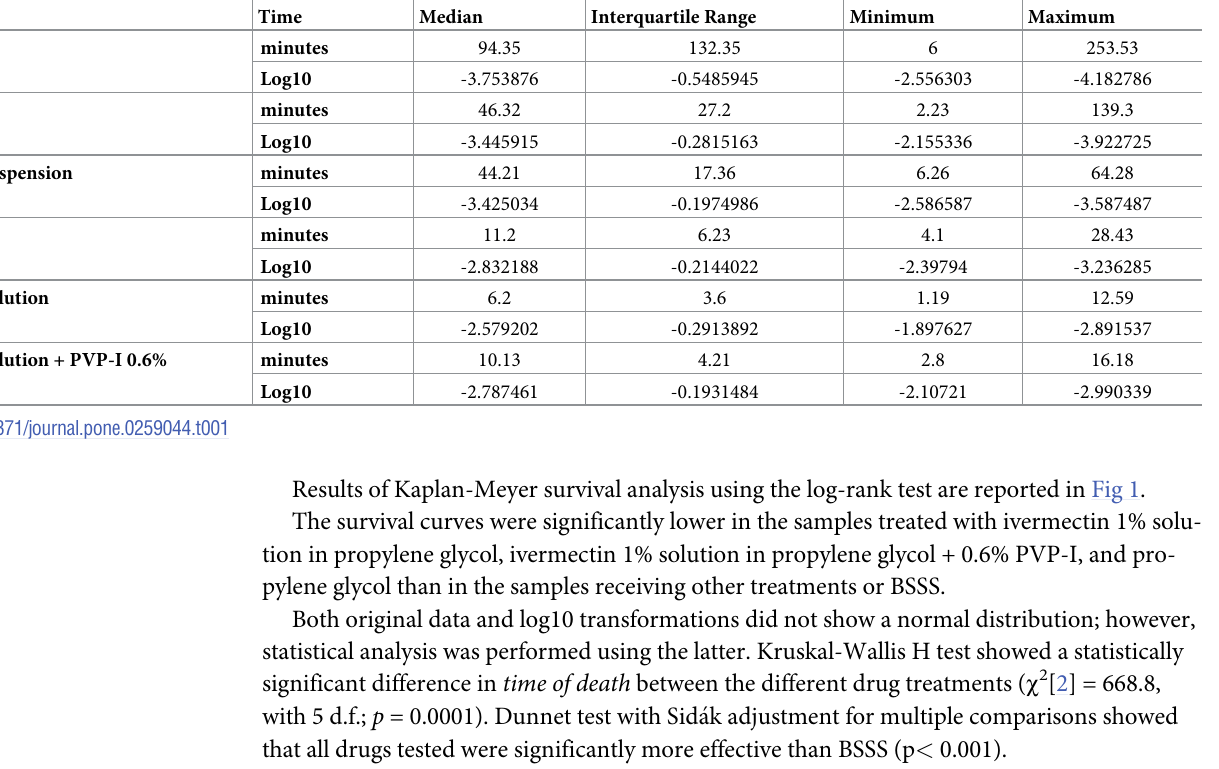
Table 1. Median time required by Balanced Sterile Saline Solution (BSSS), Iodim 1 , ivermectin 1% suspension in BSSS, propylene glycol, ivermectin 1% solution in propylene glycol, and a combination of ivermectin 1% solution in propylene glycol with 0.6% povidone-iodine (PVP-I) to kill L1 O . ovis larvae. Drug